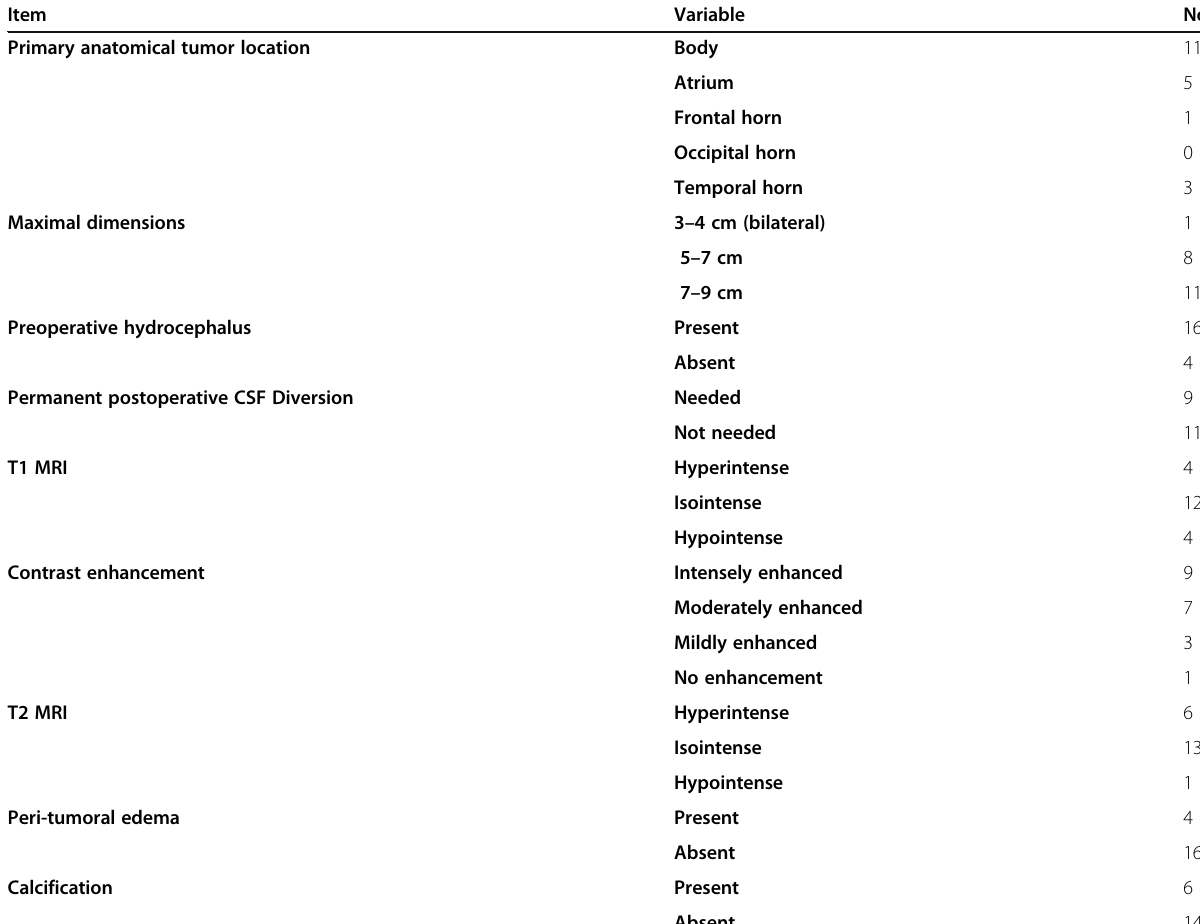
Table 3 Summary of preoperative radiologic findings